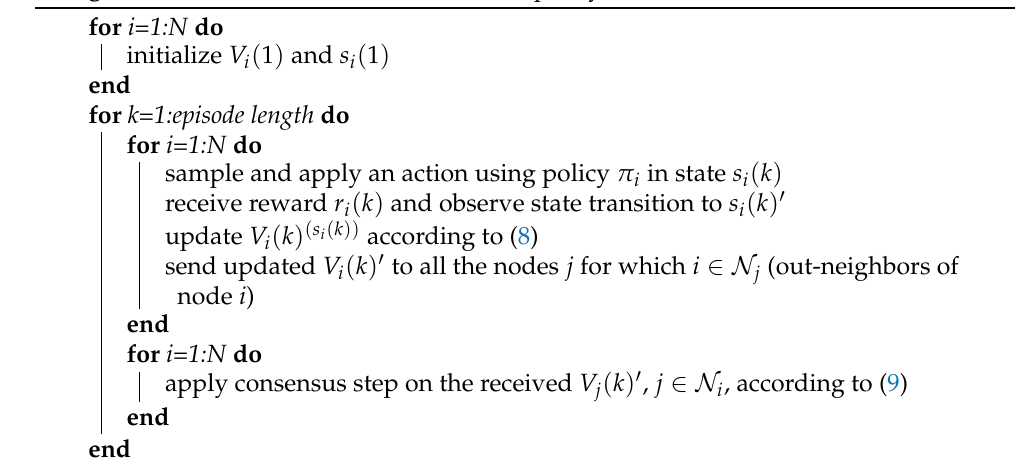
Algorithm 1: Distributed consensus-based policy